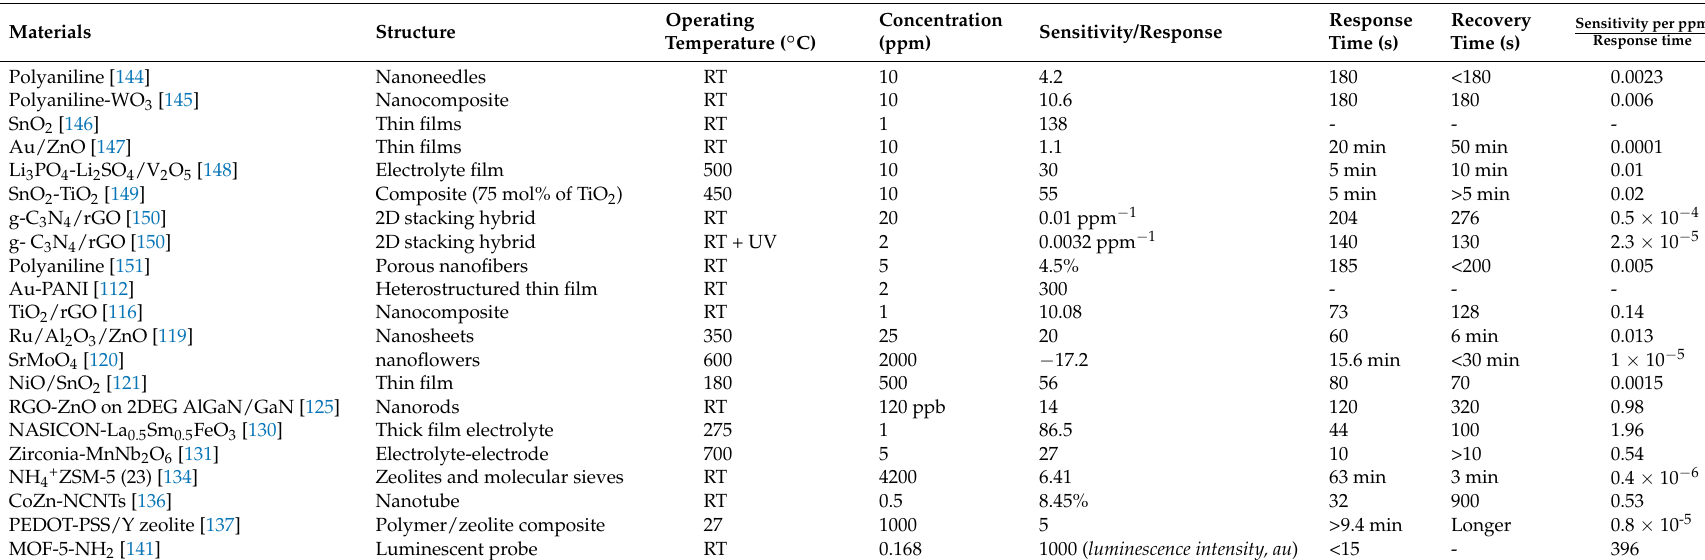
Table 2. Gas sensing properties of recently developed SO 2 gas